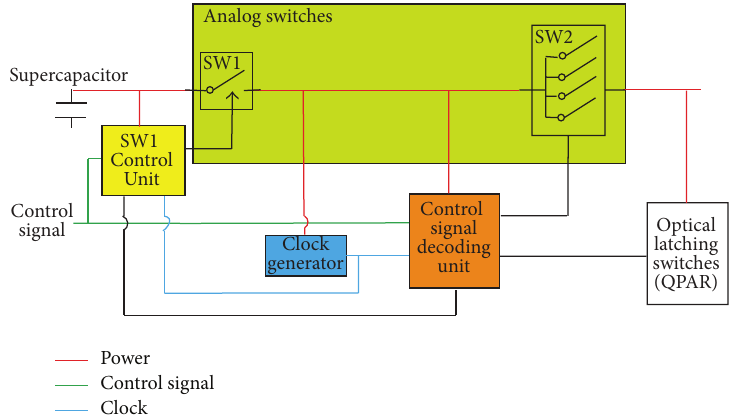
Figure 8: General architecture of QPAR control circuit.